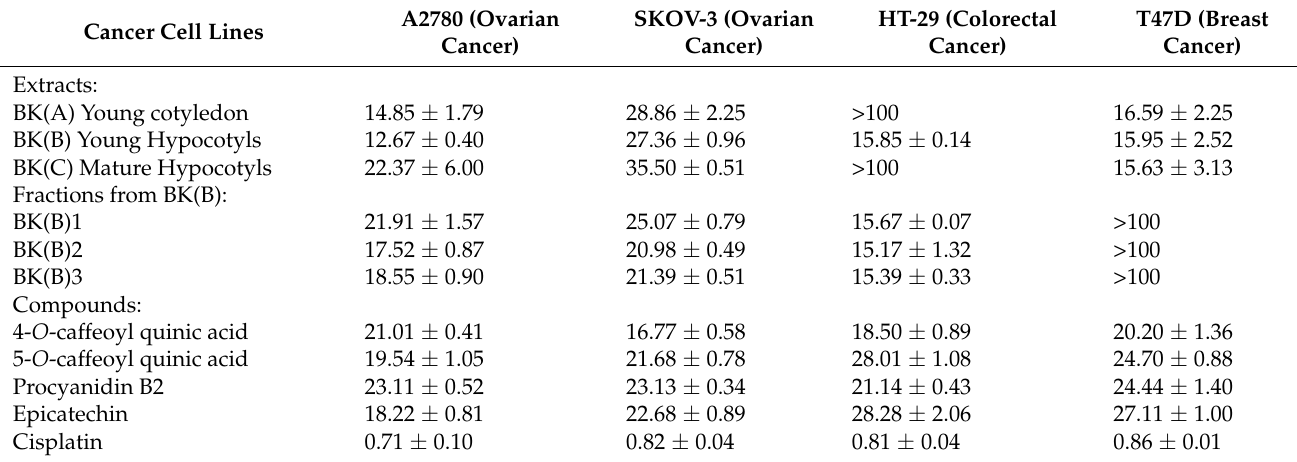
Table 1. IC 50 values ( µ g/mL) of four compounds isolated from the hypocotyl of young propagules of R. mucronata . Cancer Cell Lines